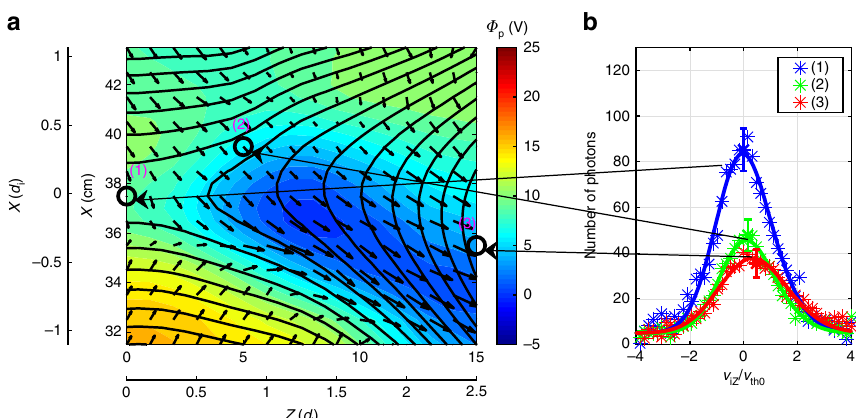
Fig. 4 Electrostatic potential pro fi le and ion acceleration during asymmetric reconnection in MRX. a The well of the saddle back shaped potential is shifted toward the low-density side and a sharp potential drop occurs in the low-density side of the exhaust region. b The ion velocity distribution in Z direction was measured by the IDSP spectroscopically. The peak of the ion distribution function in V iz increases to higher values toward downstream. Measured velocity V iz is normalized by the ion thermal velocity at the X-line. Compared to the symmetric case 13 , ions are not signi fi cantly accelerated near the separatrix on the high-density side (green line). The ion temperature in the exhaust region (red) is also slightly lower. The change of the in-plane potential pro fi le is responsible for these differences. Error bars are the square root of the number of